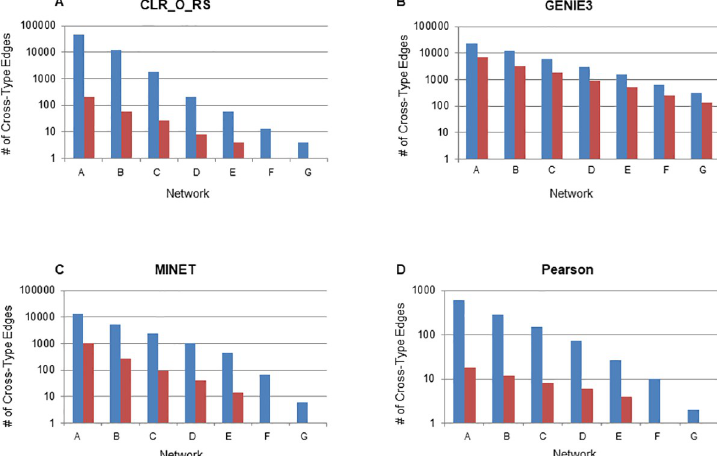
(red bars). (B) Similar analysis with GENIE3, (C) Similar analysis with MINET, (D) Similar analysis with PCC.